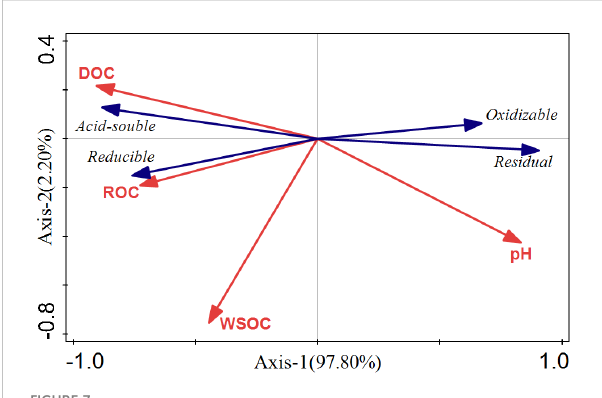
FIGURE 7 RDA ranking of Cd form and soil properties in rhizosphere